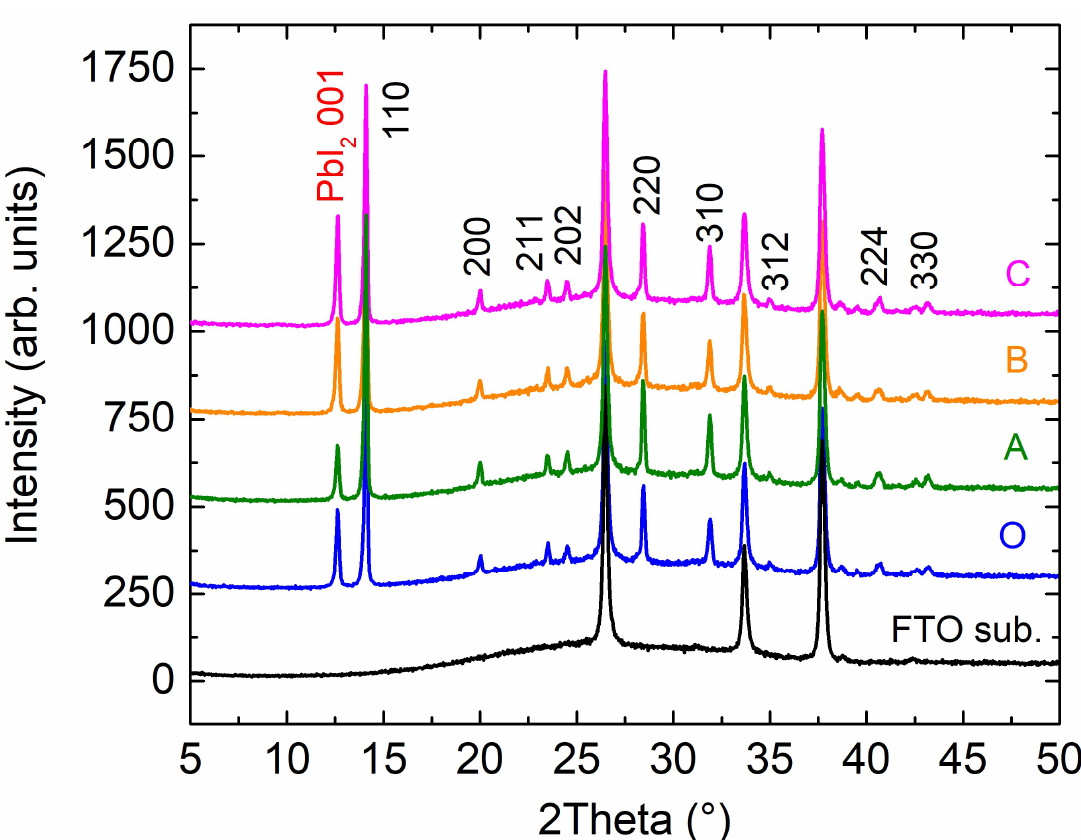
Figure 2. XRD patterns of the deposited films, in γ-butyrolactone with acid additives after the thermal treatment in nitrogen atmosphere (RH 20 ± 3%). The films are named O (no acid additive), A (acetic acid), B (formic acid) and C (trifluoracetic acid).